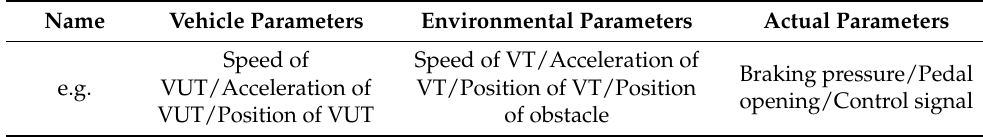
Table 2. Parameters required by the verification system.